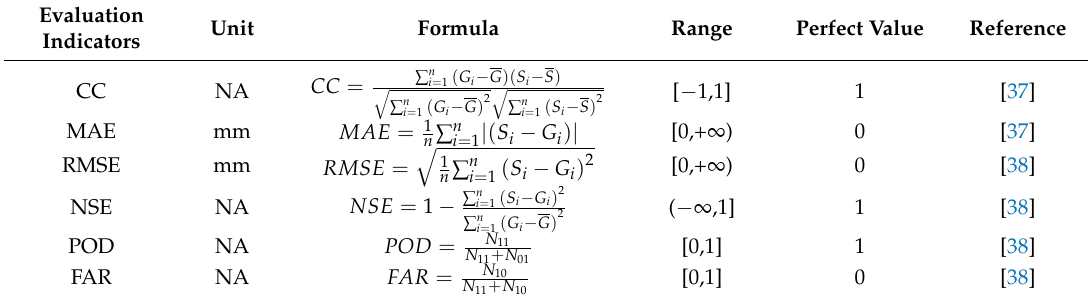
Table 3. Descriptions of evaluation indicators. Notation: n , number of samples; S i , satellite precipitation data; G i , rain gauge observations; S , mean values of satellite precipitation data; G , mean values of